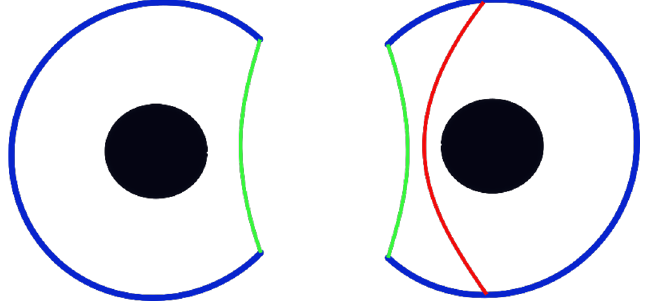
Figure 6 . A time slice of three dimensional holographic dual of the thermofield double state on two disjoint universes (a BTZ black hole). We choose each universe to be AdS 2 (blue intervals). CFT on this segment is dual to the bulk region surrounded by the segment and the probe brane (green line) [52]. In the right gravitating universe we have a black hole. The red line is the RT surface which ends on the two horizons of the boundary black